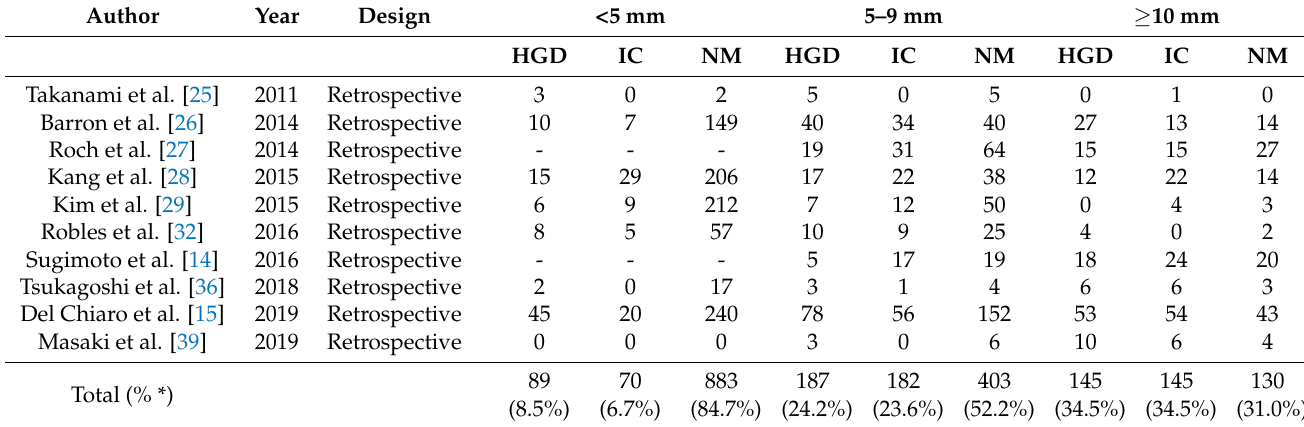
Table 2. Characteristics of included article with postoperative histology diagnosis of HGD and